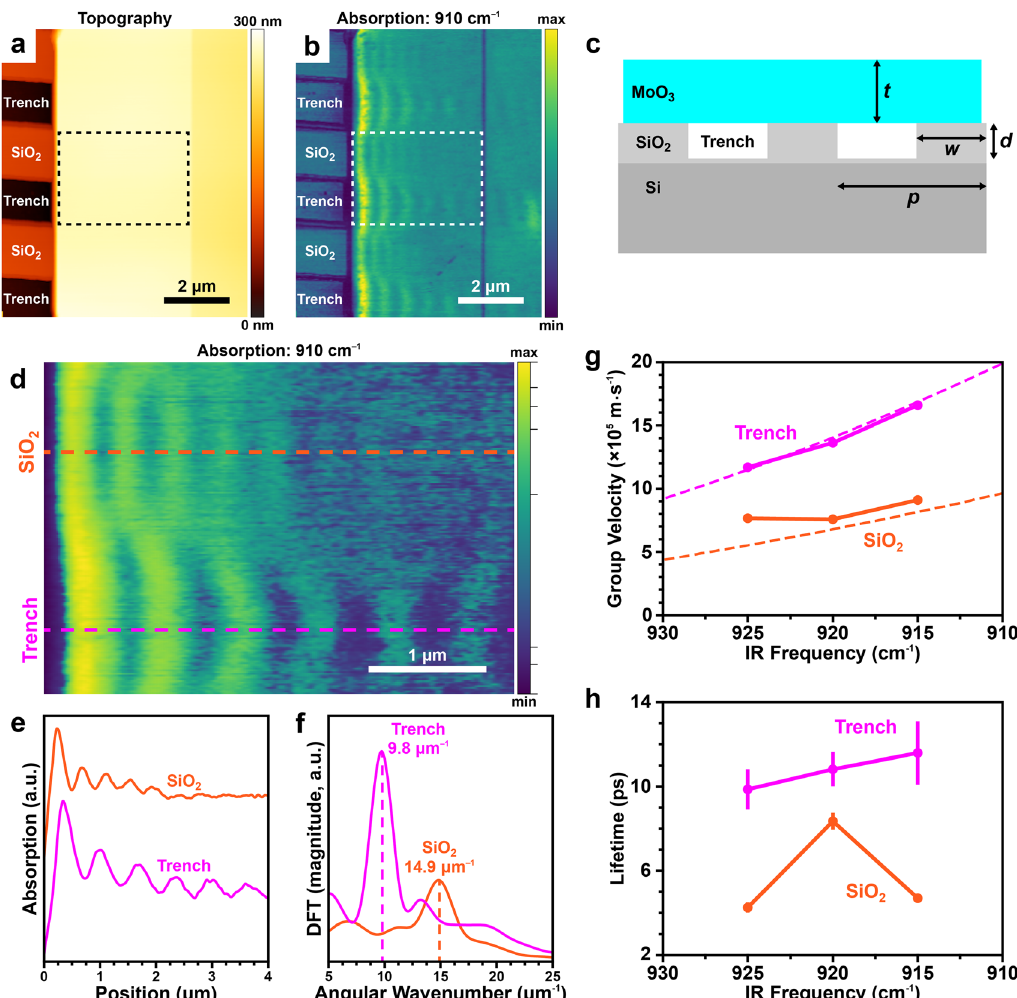
Figure 3: Topographically patterned substrates enable control over hyperbolic phonon polariton (HPhP) propagation. (a) Topography, (b) photothermal induced resonance (PTIR) absorption map at 910 cm − 1 , and (c) schematic of a MoO 3 fl ake (thickness t ≈ 185 nm) deposited on one-dimensional SiO 2 grating lines (width w ≈ 1.4 µm, pitch p ≈ 3 µm) separated by trenches of depth d ≈ 95 nm. (d) Magni fi ed PTIR absorption map at 910 cm − 1 of the region enclosed by the dashed rectangles in (a) and (b). (e) Averaged (165-nm-wide) absorption line pro fi les measured along the indicated paths in (d). (f) Magnitudes of the discrete Fourier transforms (DFTs) of the absorption pro fi les shown in (e); cubic spline interpolation plotted. Peaks in the respective DFT power spectra indicate that HPhPs propagate with higher opticalcompressions( ≈ 1.5 × ) inregionsoftheMoO 3 fl akeindirectcontactwith theSiO 2 substratecomparedtosuspendedregions,abovethe trenches. (g) Group velocities and corresponding (h) HPhP lifetimes. Dashed lines in (g) represent the theoretical group velocity of fi rst order, edge-launched HPhPs. Error bars in (g) and (h) represent uncertainties in the mean values, propagated from least-squares fi t covariance matrices.Notethatanon-linearcolorscaleisusedin(d)withbandsofapproximatelyequalchangesinabsorptionintensityindicatedwithtick marks along the right side of the color